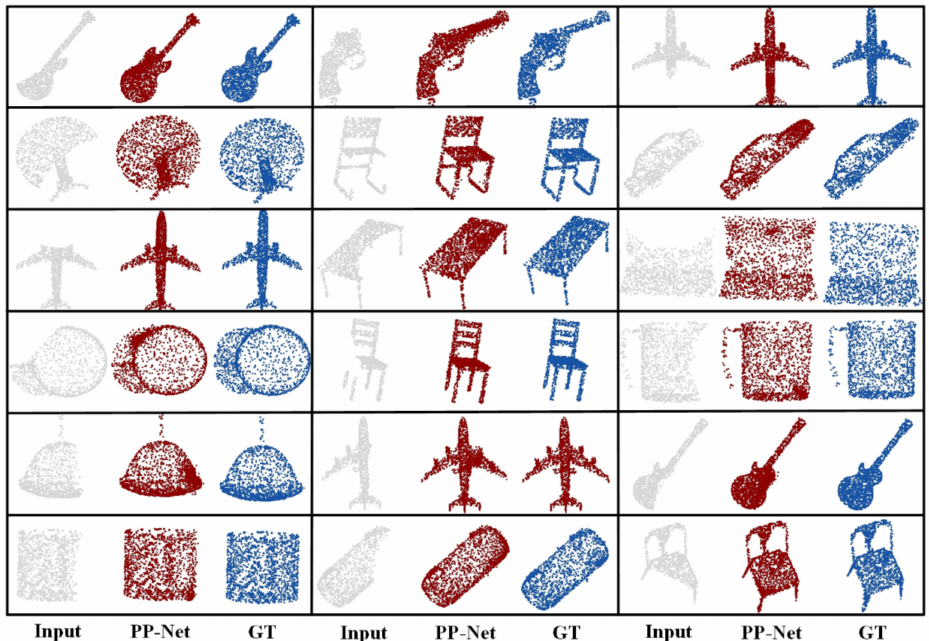
Figure 6. Visualization of partial point cloud completion results. “Input” represents the input incom- plete point cloud, “PP_Net” represents the completion result of the network, and “GT” represents the ground